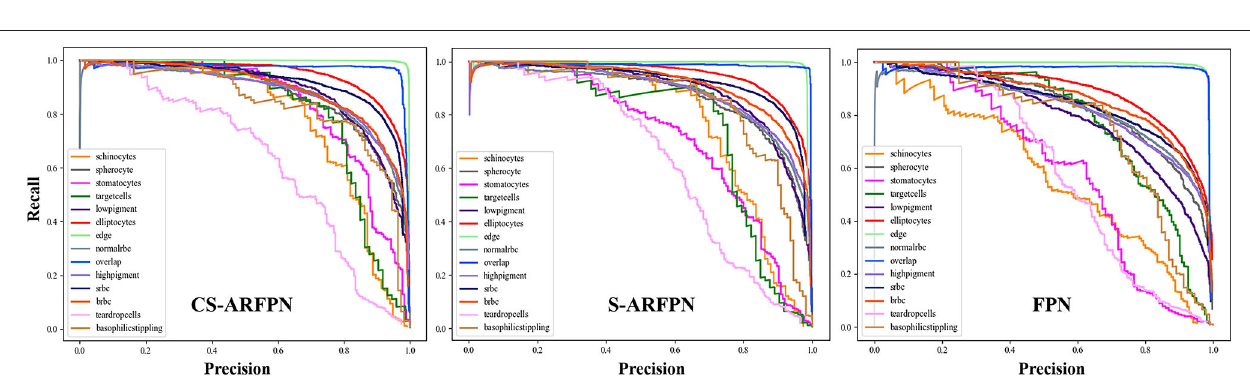
to the upper right, the larger the area under the line and the better the performance of the model. The PR area under the curve (PR- AUC) of the three models is 0.798, 0.86, 0.869, respectively. Thus, the CS-ARFPN model achieves the best performance, followed by